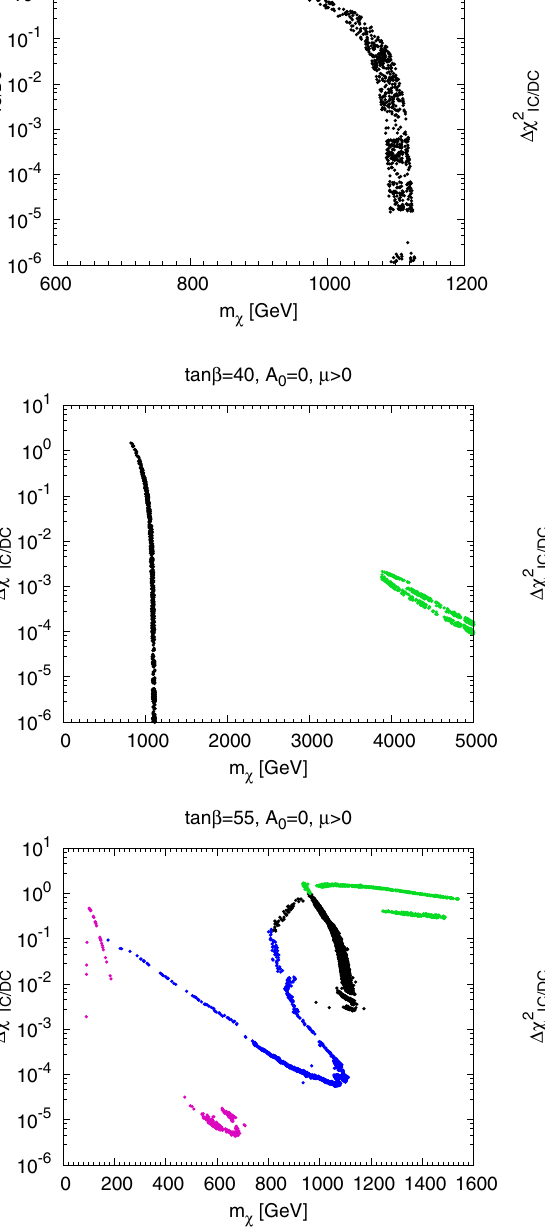
Sun [64–66] with calculations for points along the dark matter strips for tan β = 5 , 20 , 40 , 50 , 55 and 56 with A 0 = 0 and μ >